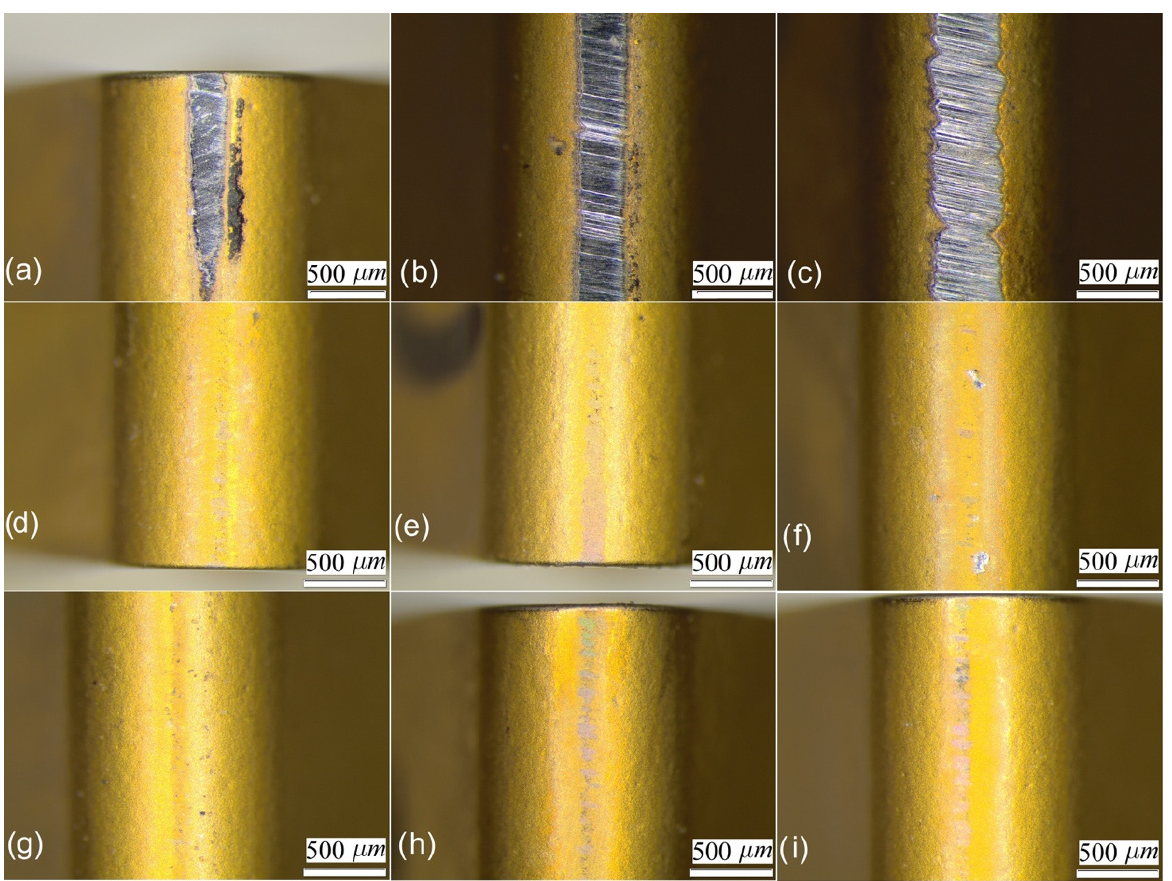
Figure 11. Tool wear evolution. Dry: ( a ) 1000 m, ( b ) 2000 m and ( c ) 3000 m, flood: ( d ) 1000 m, ( e ) 2000 m and ( f ) 3000 m, LIL: ( g ) 1000 m, ( h ) 2000 m and ( i ) 3000 m.